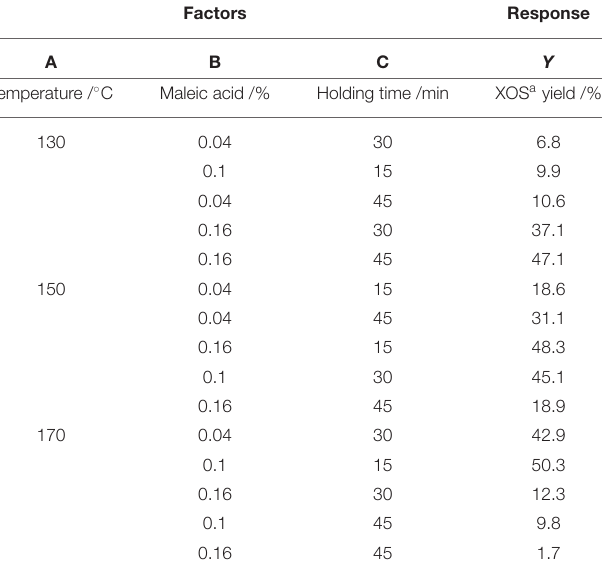
TABLE 1 | The experimental design and response value (XOS yield).